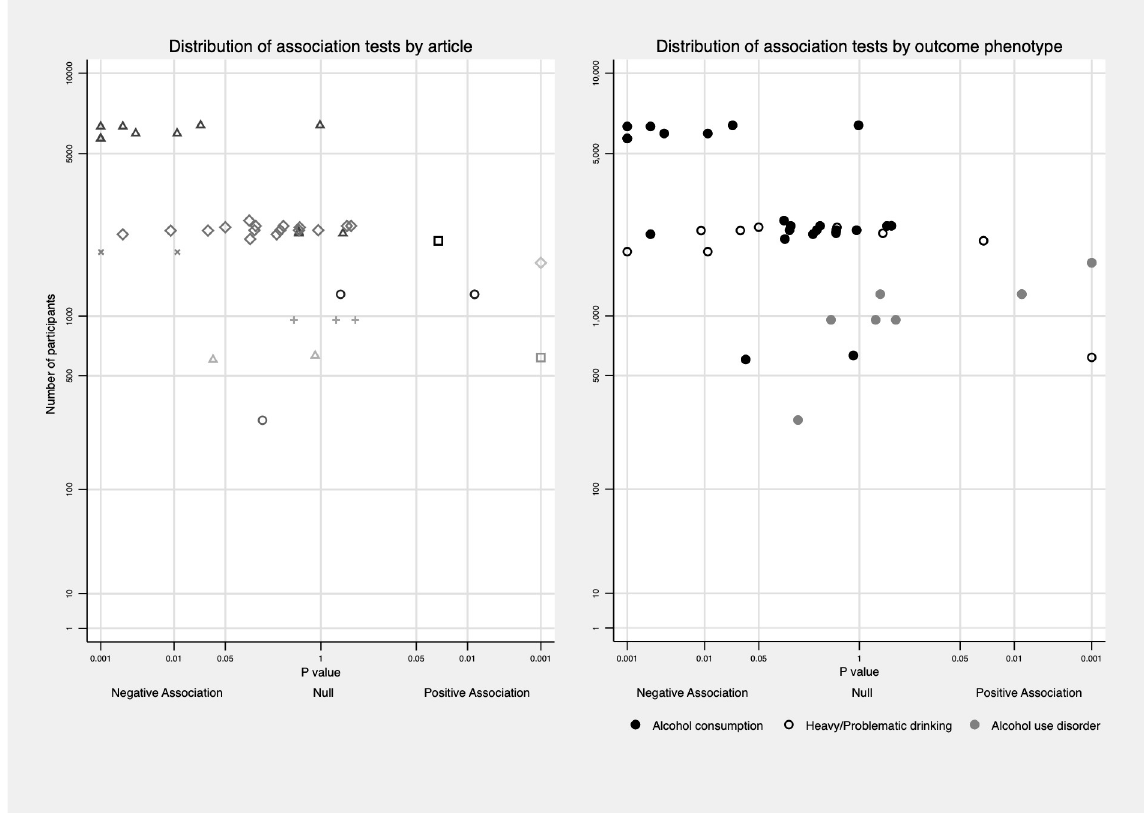
Fig 4. Distribution of association tests between INT and subtypes of alcohol use behaviours. Distribution of association tests clustering in one article was plotted on the left to show the non-independence among tests.